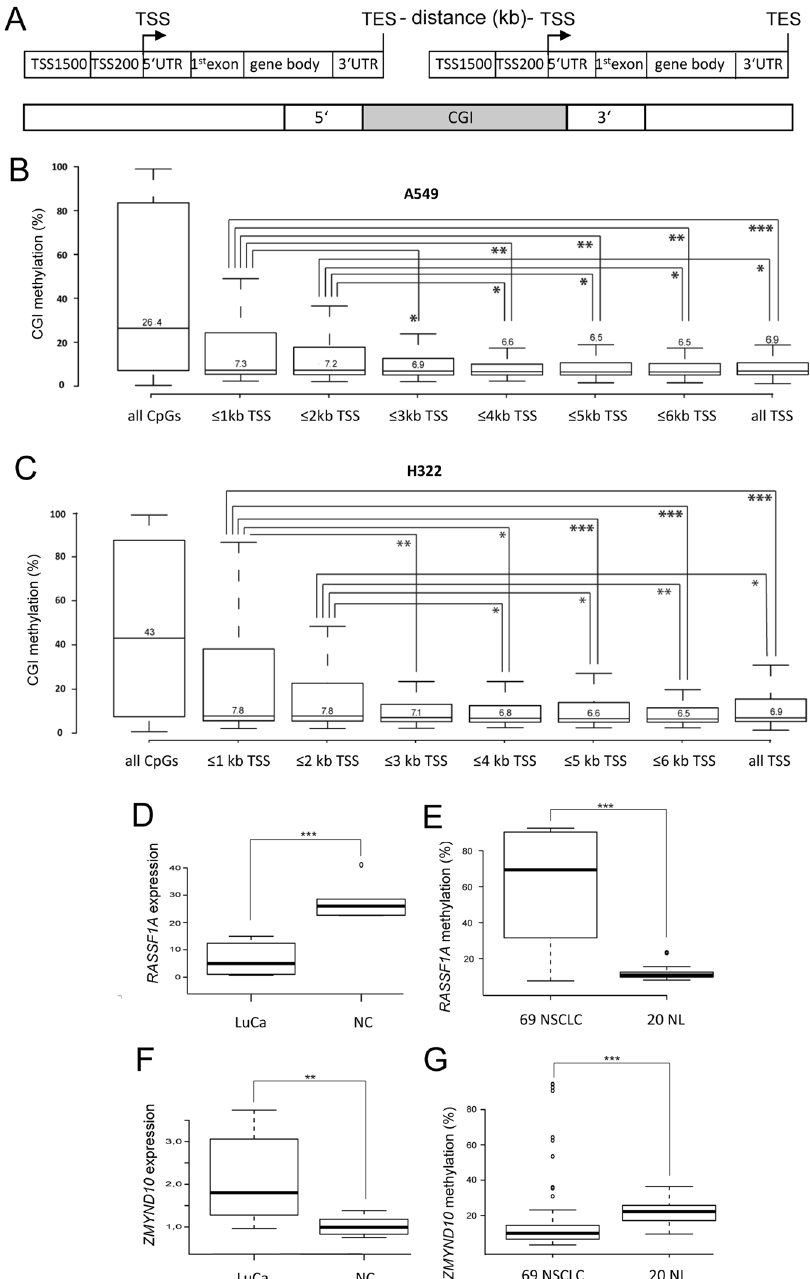
Figure 4. Epigenetic silencing of downstream genes located in tandem orientation. ( A ) Outline of the organization of tandem oriented genes with a CpG island at the transcriptional end site (TES) of the upstream gene and the transcriptional start site (TSS) of the downstream gene. ( B ) Methylation level of TSS-associated CGI in A549 cells was plotted depending on the distance between TES and TSS in kb (n = 258 to 297 CGI). Methylation as detected using 450 K bisulfite bead chip arrays. “All CpGs” and “all TSS” indicate the methylation level of CpGs located at CGI and TSS-associated CGI, respectively. ( C ) Methylation levels of tandem oriented downstream CGI in H322 cells. ( D ) RASSF1A expression levels were analyzed in lung cancer cell lines (LuCa: A427, A459, H322 and H358) and normal lung cells (NC: PAF and PASMC) by qRT-PCR. RASSF1A expression was normalized to the GAPDH level. ( E ) Methylation of RASSF1A was analyzed in 69 non small cell lung cancer (NSCLC) cell lines and 20 normal lung tissues (NL). For details see also Fig. 3. ( F ) ZMYND10 expression levels were analyzed in LuCa and NC as measured by qRT-PCR and normalized to GAPDH levels. ( G ) Methylation of ZMYND10 was analyzed in 69 NSCLC cell lines and 20 NL. * p < 0.05, ** p < 0.01 and *** p <